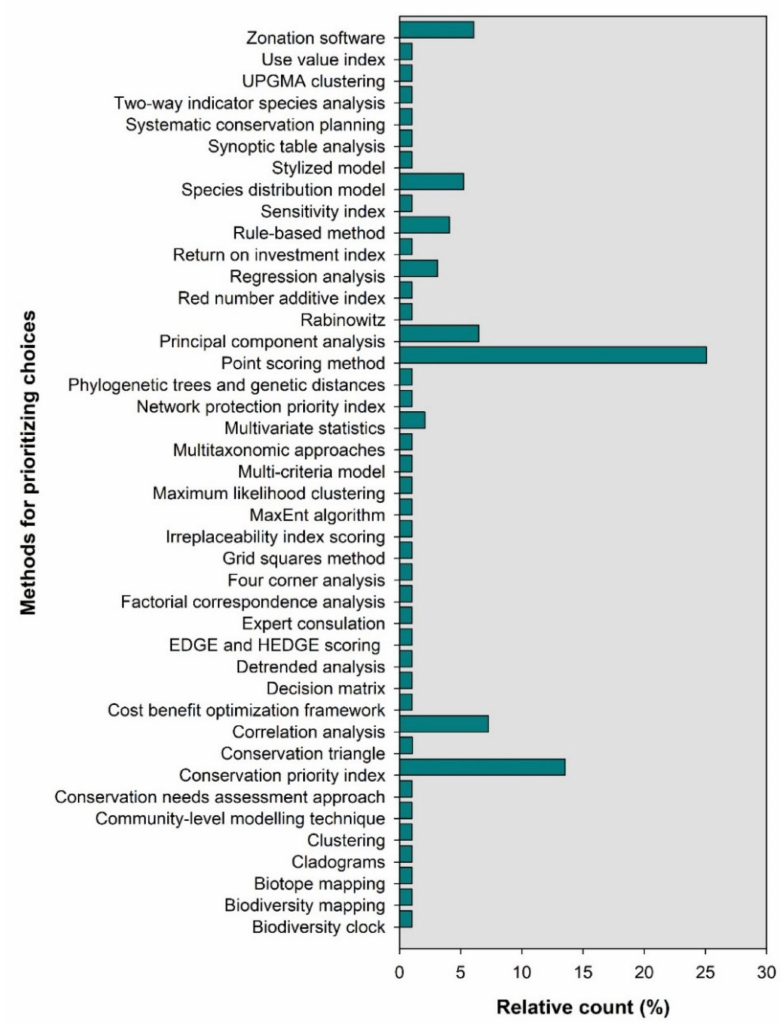
Figure 3. Relative count of the identified methods for prioritizing conservation choices for flora